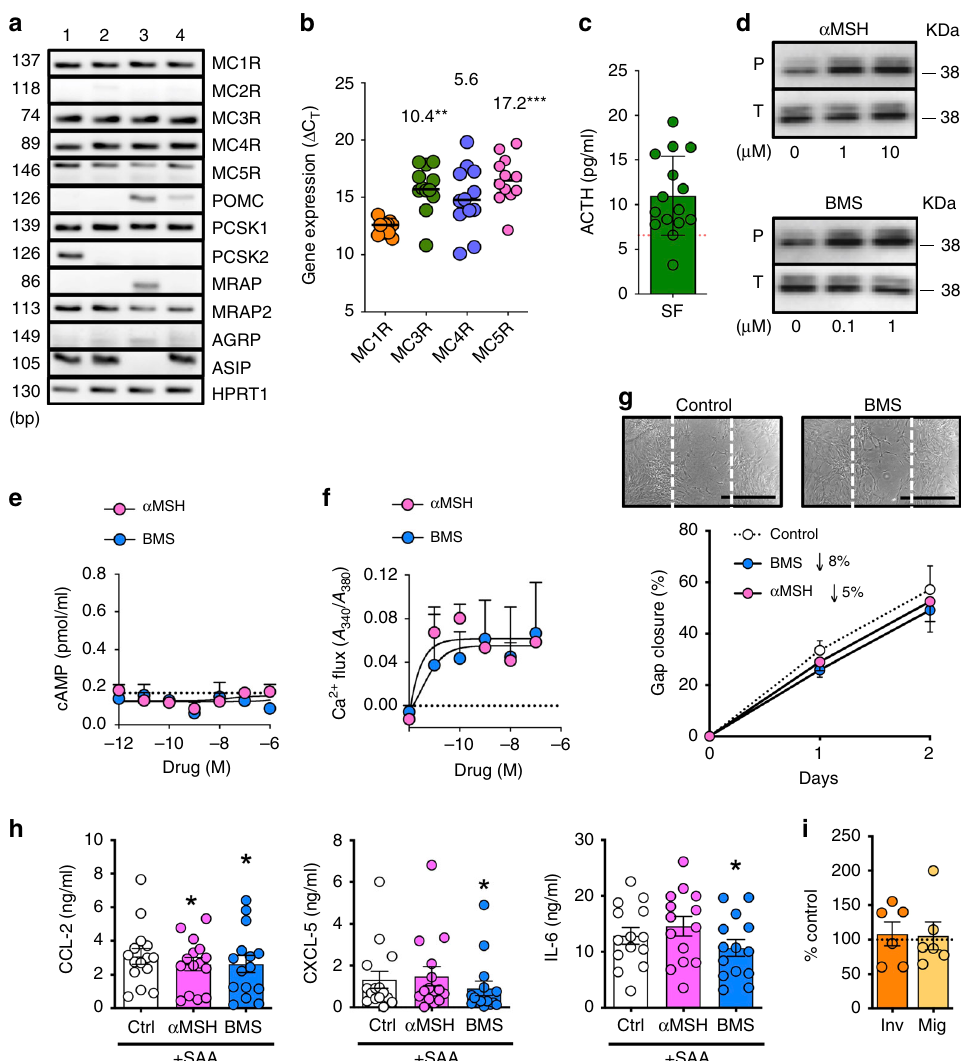
Fig. 1 The Melanocortin (MC) system in synovial fi broblasts. a Expression of several components of the MC pathway in RA SF fi broblasts as determined by end-point PCR using 1 μ g of RNA ( n = 4). b MCRs expression was further analyzed by real-time PCR using 1 μ g of RNA. Cycle threshold ( C T ) values normalized against the reference control HPRT1 are shown (lower C T values denote higher expression). Numbers above bars indicate overexpression of MC1R compared to the other receptors calculated as 2 − ΔΔ Ct . Data represent mean values, min to max range ( n = 12, one-way ANOVA, Dunn ’ s correction; ** p < 0.01; *** p = 0.001). c ACTH quanti fi cation in supernatants on SF cultured for 7 days without media replacement. Data are mean ± SD ( n = 15). Dotted line represents values quanti fi ed in media without incubation with SF cells, serving as a negative control. d ERK-phosphorylation as analyzed by western blotting after 5 min stimulation of SF with MC agonists at the indicated concentrations. e Intracellular cAMP accumulation was quanti fi ed by EIA after 15 min SF cell stimulation with BMS or α MSH. The adenylyl cyclase activator forskolin (3 μ M) was used as a positive control, yielding 0.58 pmol/ml. Data are mean ± SE ( n = 3). f Ca 2 + mobilization in SF upon addition of α MSH or BMS (from 1 μ M then serially diluted up to 10 pM), and recorded for 86 s. Ionomycin (1 μ M) was used as a positive control, yielding 0.15 units of absorbance ratio at 340/380 nm. Data are mean ± SE ( n = 3). g In vitro wound